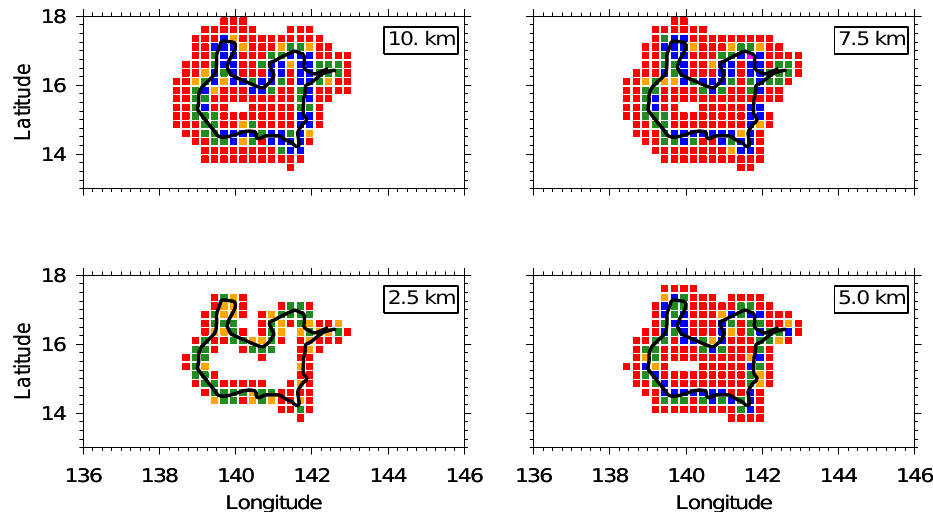
Fig. 4. Same as in Fig. 3, but for the error associated with the component of the gridded velocity along the eigen-direction with the smallest eigenvalue.